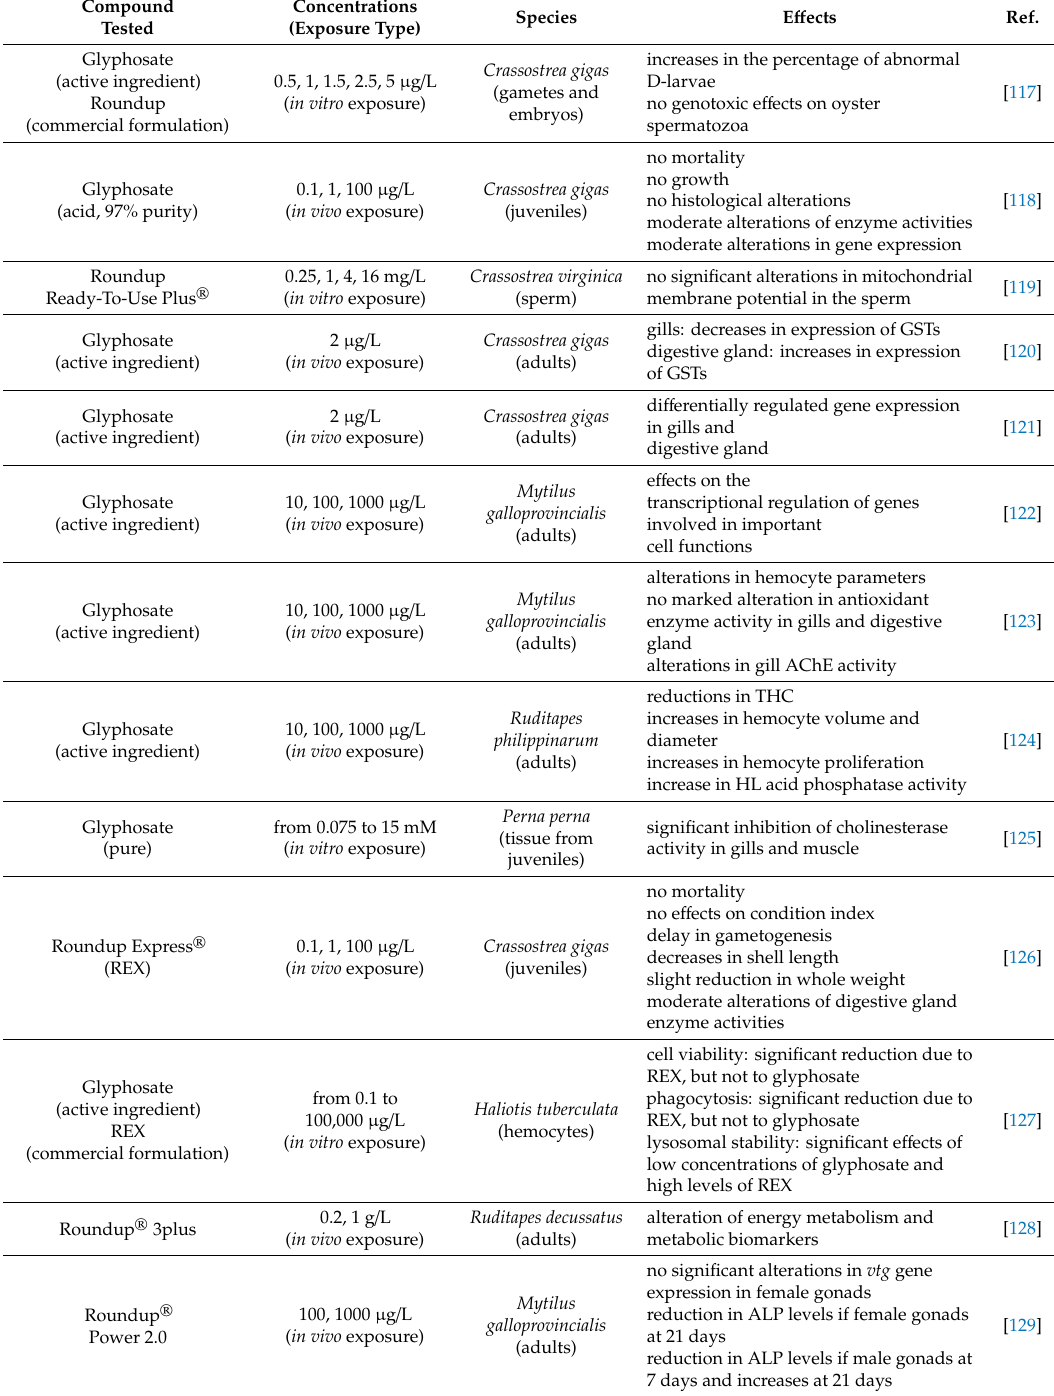
Table 3. E ff ects of glyphosate (as active ingredient) and its commercial formulations in mollusks. Abbreviations : AChE (acetylcholinesterase); ALP (alkali labile phosphate); GST (glutathione S-transferases); HL (hemocyte lysate); REX : Roundup Express ® ; THC (total hemocyte count); Vtg